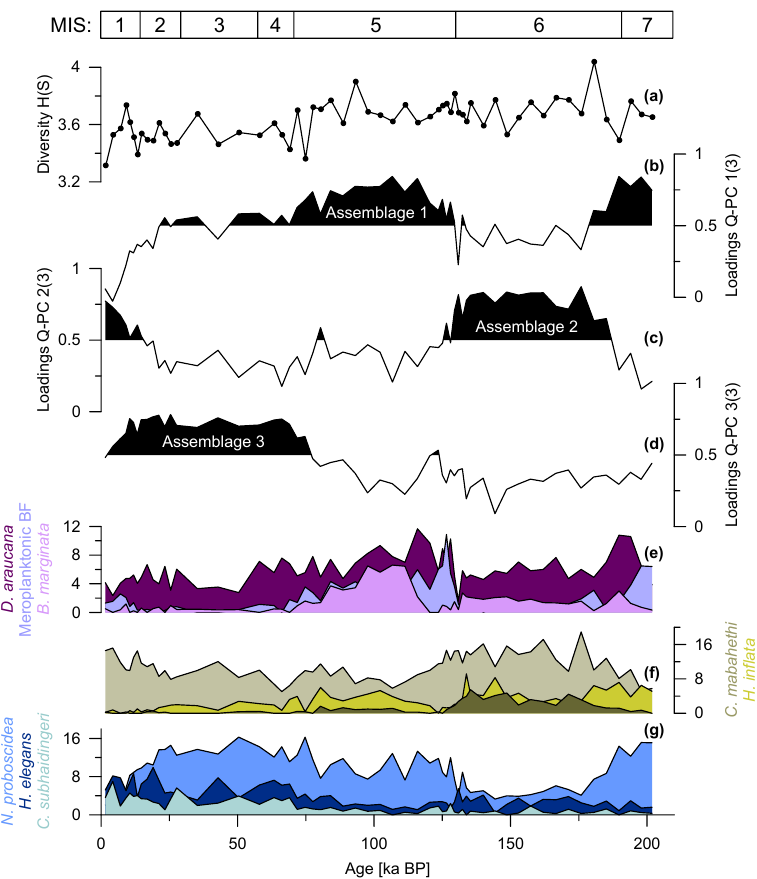
Figure 7. Comparison of benthic foraminiferal faunal records of core SO236-052-4 from the central part of the Maldives Inner Sea. (a) Shannon–Wiener diversity index H ( S ), (b–d) Q-mode benthic foraminiferal assemblages, including the N. proboscidea and D. arau- cana fauna (assemblage 1), the C. mabahethi fauna (assemblage 2), and the N. proboscidea and H. elegans fauna (assemblage 3). Loadings ≥ 0.5 are defined as significant after Backhaus et al. (2008). (e–g) Distribution of selected important and associated benthic foraminiferal taxa, given in percent. The meroplanktonic benthic foraminifera (BF) are comprised of the genera Cymbaloporetta and Tretomphaloides